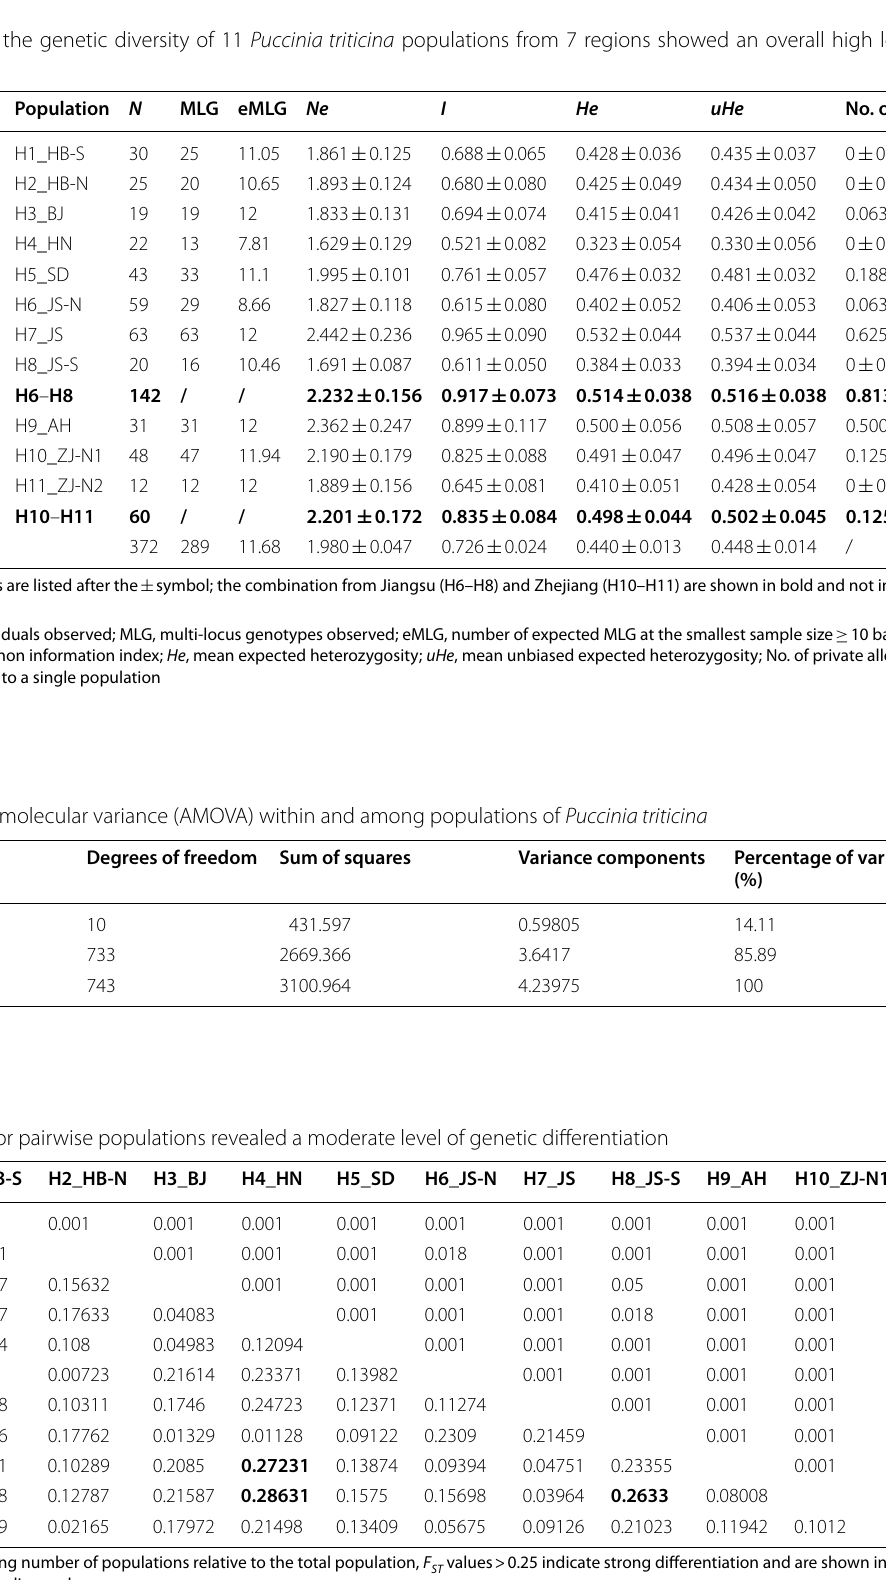
F ST , mean pairs of alleles between individuals within populations